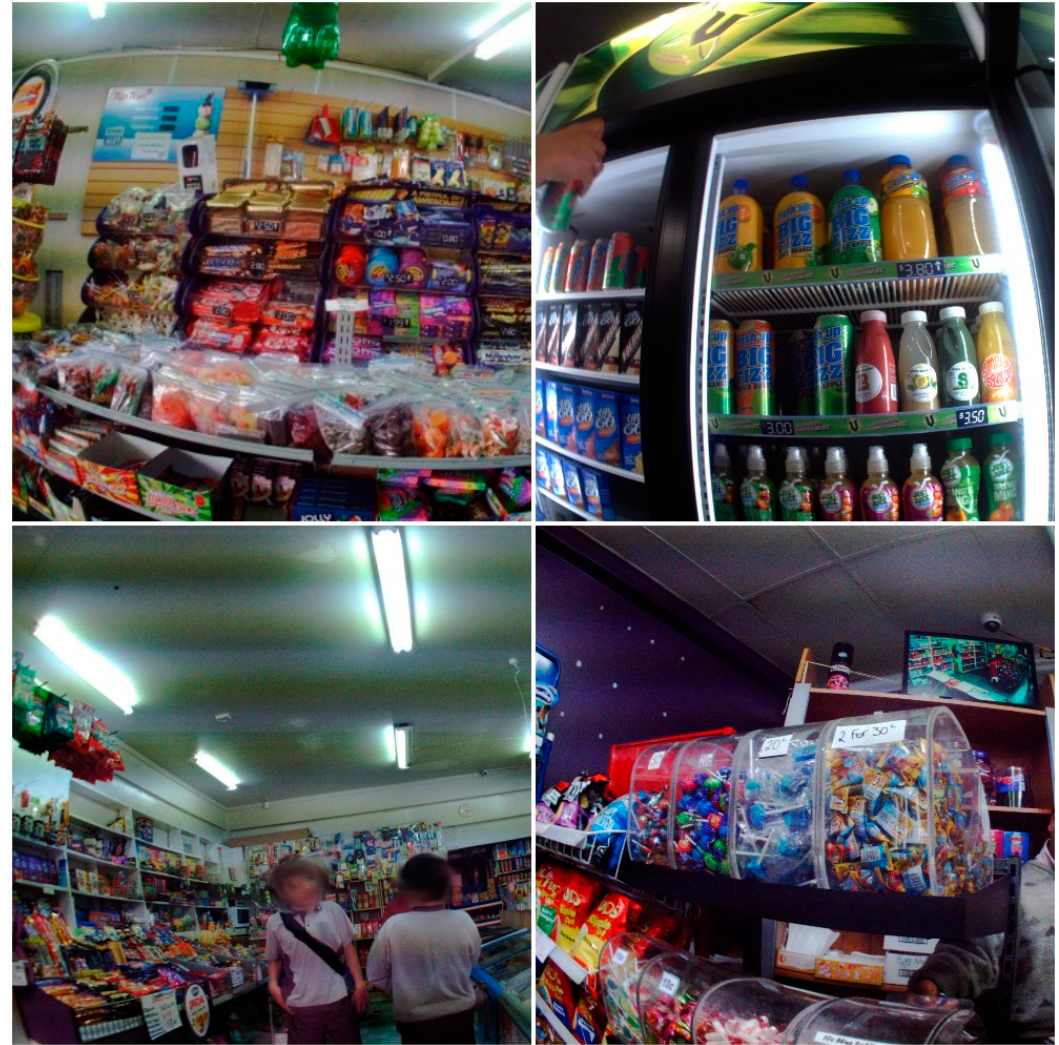
Figure 1: Noncore food and drink items available to children in convenience stores. Top left: single-serve confectionary including lolly-mix. Top Right: Sugary drinks in a branded refrigerator—note branding for “V” at the top and on shelves. Bottom right: single-serve confectionary note for price promotion of 2 for 30 c. Bottom left: image shows the “arms reach” of confectionary.